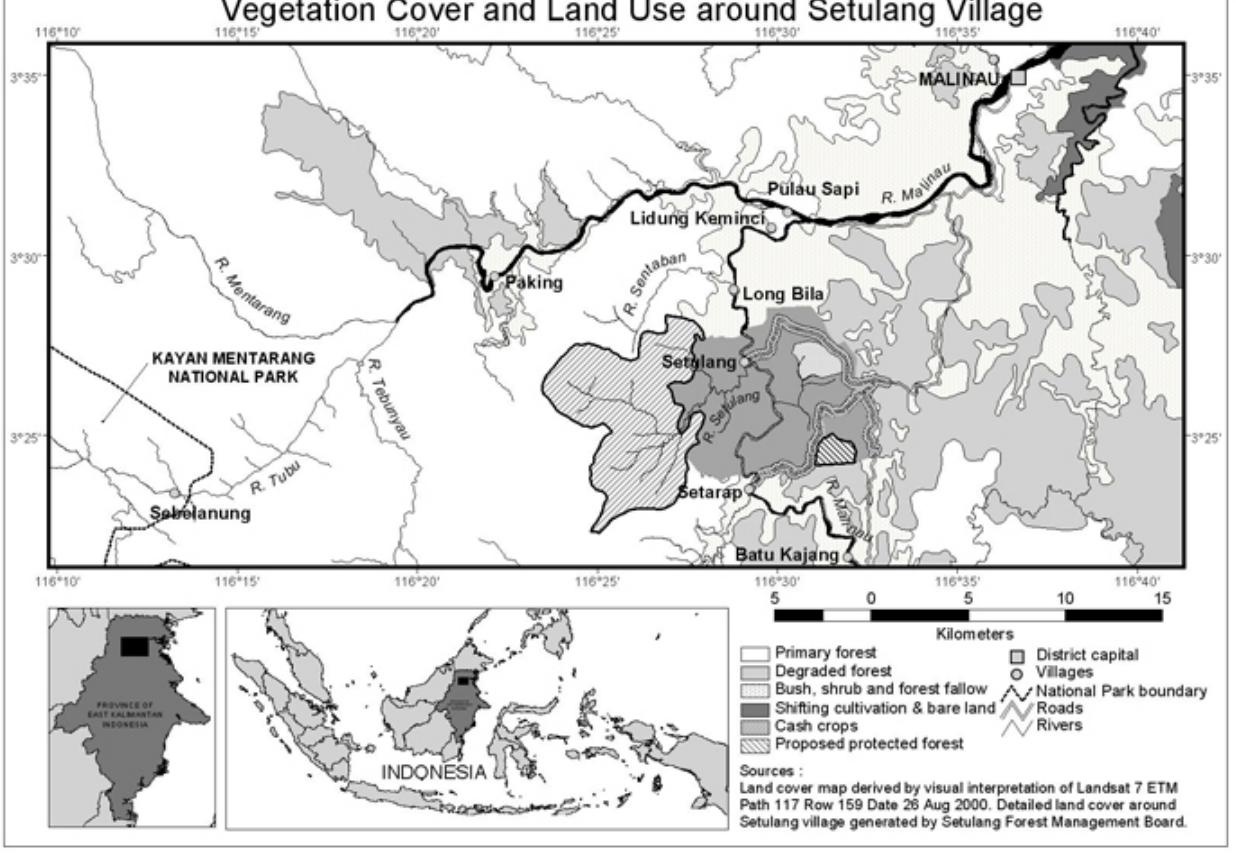
Fig. 1. Location of Setulang Village in Malinau District, East Kalimantan, Indonesia, showing generalized vegetation cover and land use, as well as the two protected community forest areas (one proposed) referred to in the